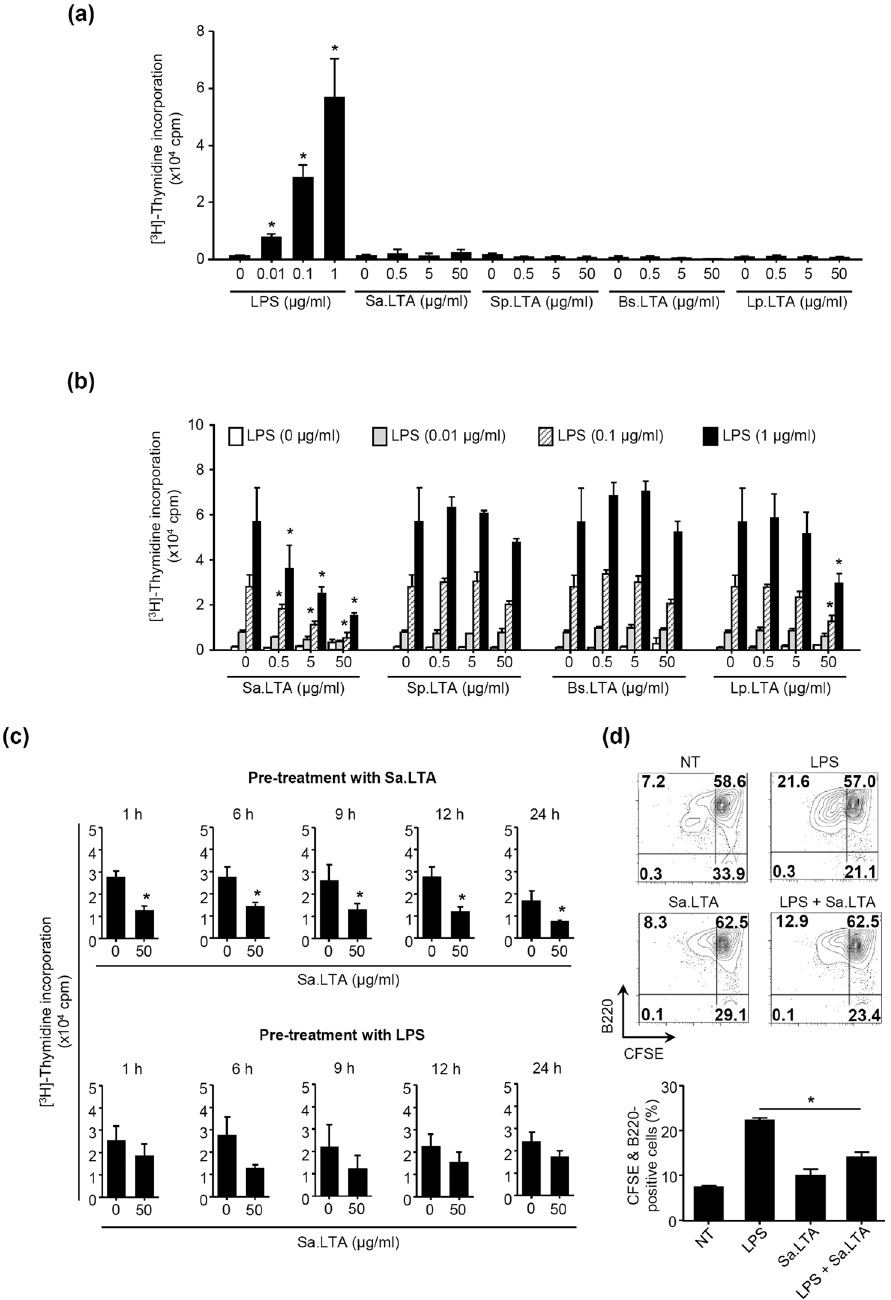
Figure 1. Staphylococcal LTA inhibits LPS-induced B cell proliferation. ( a ) Splenocytes (1 × 10 6 cells/ml) were stimulated with S . aureus LTA (Sa.LTA), S . pneumoniae LTA (Sp.LTA), B . subtilis LTA (Bs.LTA), L . plantarum LTA (Lp.LTA), or E . coli LPS at the indicated concentrations for 72 h. Then, the cells were pulsed with 0.5 μ Ci/well of [ 3 H]-thymidine for the last 6 h of culture. Cell proliferation was determined by [ 3 H]-thymidine incorporation. * P < 0.05 compared with control culture without LPS stimulation. ( b ) Splenocytes were stimulated with LTAs and/or LPS at the indicated concentrations for 72 h and cell proliferation was determined as described above. * P < 0.05 compared with control culture without LTA stimulation. ( c ) Splenocytes were pre-treated with Sa.LTA (50 μ g/ml) for 1, 6, 9, 12, or 24 h and subsequently stimulated with LPS for 72 h ( Upper panel ). Conversely, splenocytes were pre-treated with LPS (0.1 μ g/ml) for 1, 6, 9, 12, or 24 h and then stimulated with Sa.LTA (50 μ g/ml). At 72 h incubation after LPS treatment, cell proliferation was determined as described above ( lower panel ). * P < 0.05 compared with control culture without Sa.LTA stimulation. All data are expressed as the average count per minute (cpm) ± standard deviation of three separate experiments. ( d ) CFSE-labeled splenocytes (1 × 10 6 cells/ml) were stimulated with Sa.LTA (50 μ g/ml) and/or LPS (0.1 μ g/ml) for 72 h. Then, the cells were stained with PerCP-conjugated rat anti-mouse CD45R/B220 antibody and B cell proliferation was determined by flow cytometry. NT denotes